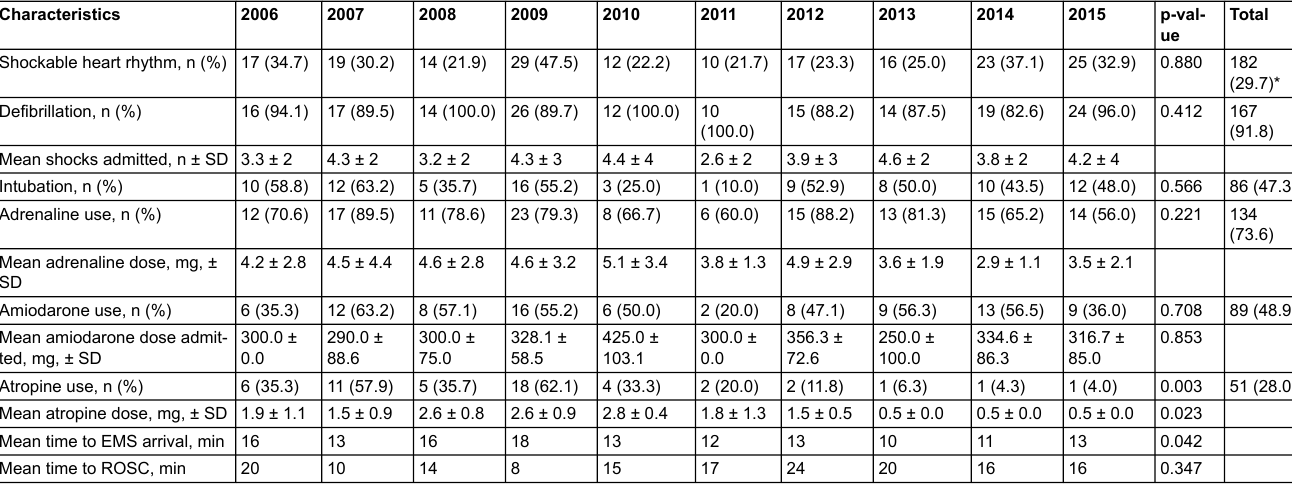
Table 4: Management details after EMS arrival at the scene.